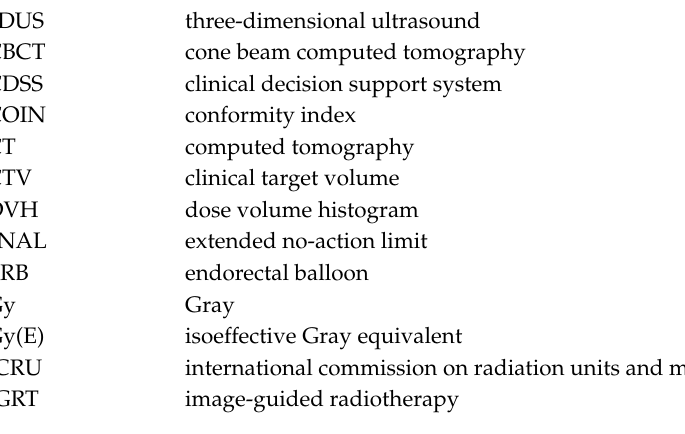
Table S1: Inter-fraction prostate displacement metrics for 3DUS and CBCT, Table S2: Stratification into best treatment technique according to the CDSS, Table S3: Stratification into worst treatment technique according to the CDSS , Table S4: Difference between the best and worst treatment technique according to the CDSS, Table S5: Difference in score between the best P-EBRT and best X-EBRT treatment techniques according to the CDSS (CBCT: no-correction), Table S6: Difference in score between the best P-EBRT and best X-EBRT treatment techniques according to the CDSS (CBCT: eNAL-correction), Table S7: Difference in score between the best P-EBRT and best X-EBRT treatment techniques according to the CDSS (CBCT: